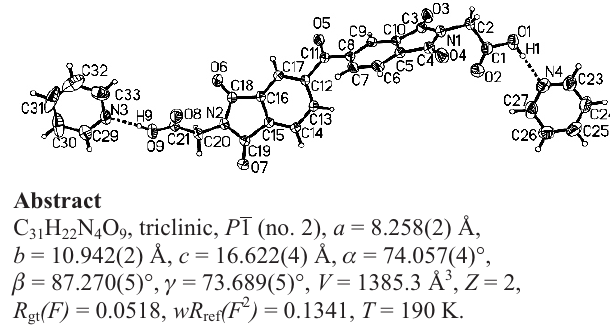
Table 1. Data collection and handling.